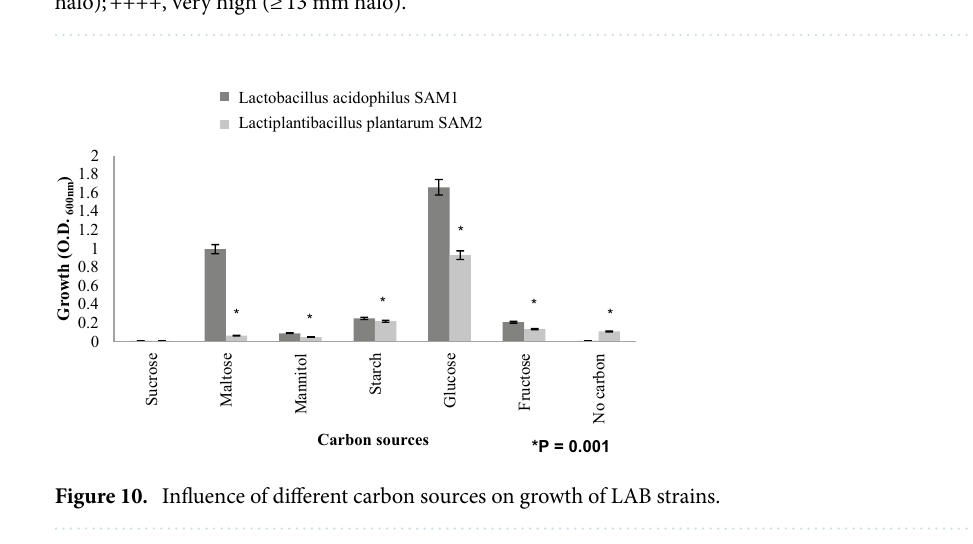
Table 2. Extracellular enzyme production of the LAB strains. Qualitative extracellular enzyme activity was observed by the appearance of halo diameter in mm around the colony, which was presented as scores as follows: nil (no halo); +, low (1–4 mm halo); ++, intermediate (5–8 mm halo); +++, high (9–12 mm halo); ++++, very high (≥ 13 mm halo).